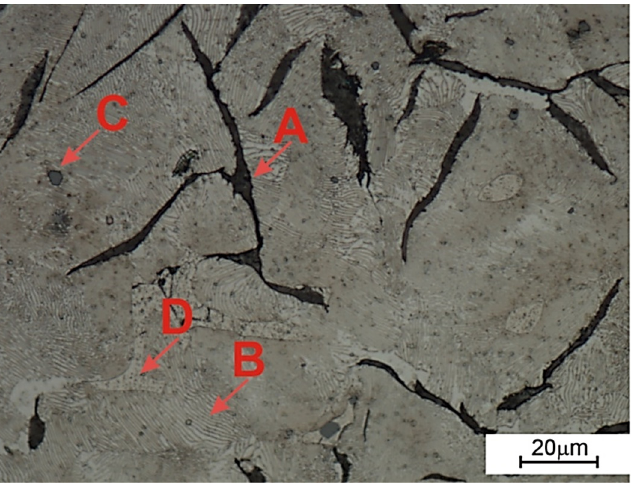
Figure 2. The microstructure of gray cast iron constituting the matrix of the composite, OM, mag. 500×, etching: Nital. ( A ) flake graphite; ( B ) pearlite; ( C ) MnS sulfides; ( D ) steadite.